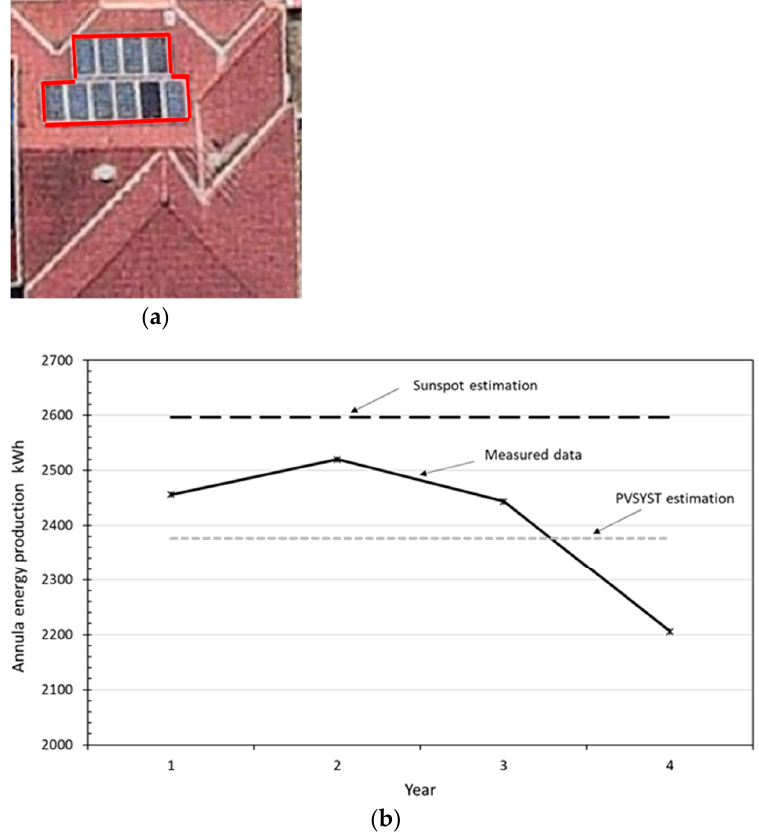
Figure 2. Verification of SunSPoT annual energy production of a 1.75 kW system. ( a ) Roof area covered by PV array, ( b ) comparison of the estimated annual energy generated by SunSPoT with four years of measured data.